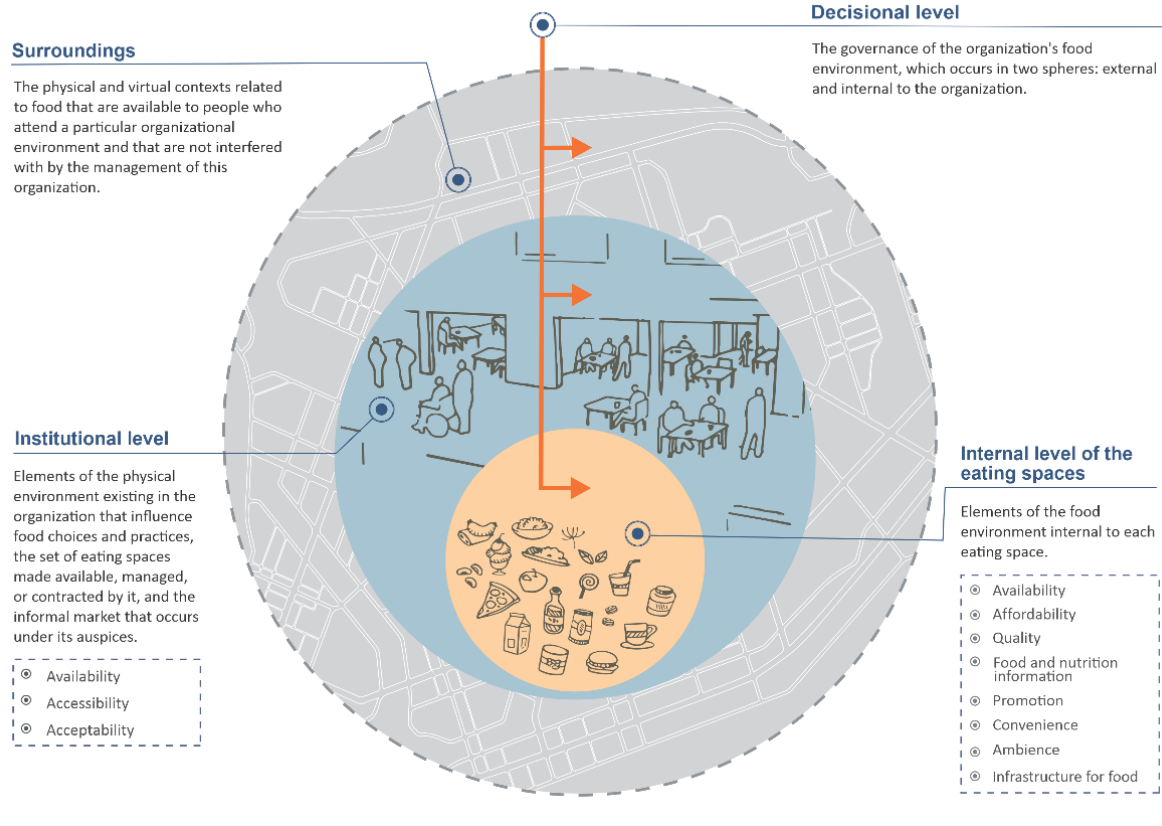
Figure 1. Conceptual model of organizational food environments.